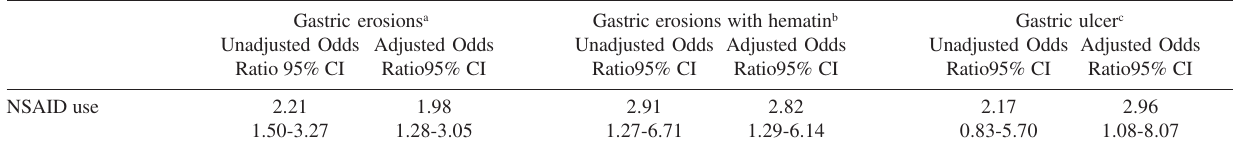
Table 3 - Results of multivariate analysis of association between nonsteroidal anti-inflammatory drugs use and the occurrence of gastric lesions